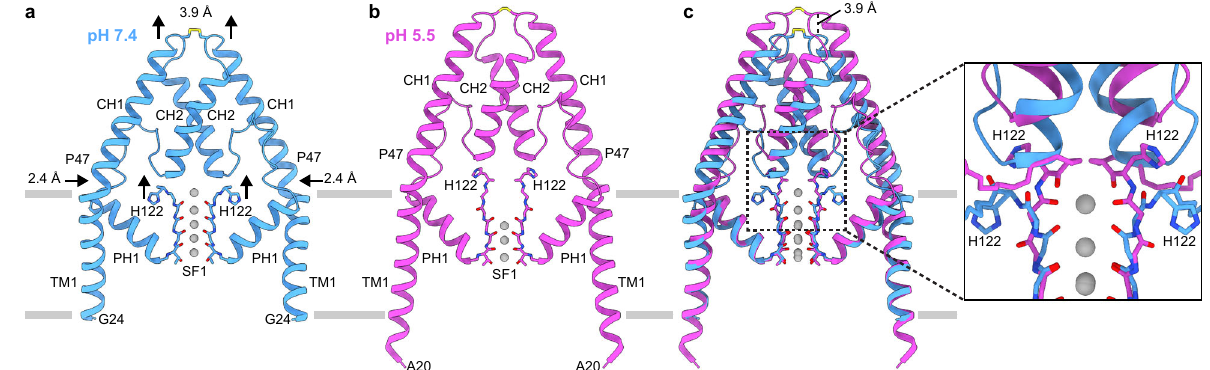
Fig. 4 Helical cap and transmembrane helix rearrangements in response to pH ext . a – c View of TM1s, helical cap, PH1s, and SF1s at ( a ) pH 7.4, ( b ) pH 5.5, and ( c ) overlaid. Arrows highlight the upward movements of H122 and helical cap and the inward movement of TM1 in response to low pH ext . c (inset) Zoomed in view of region boxed in c illustrating steric overlap between the selectivity fi lter in the low pH ext structure and helical cap in the high pH ext